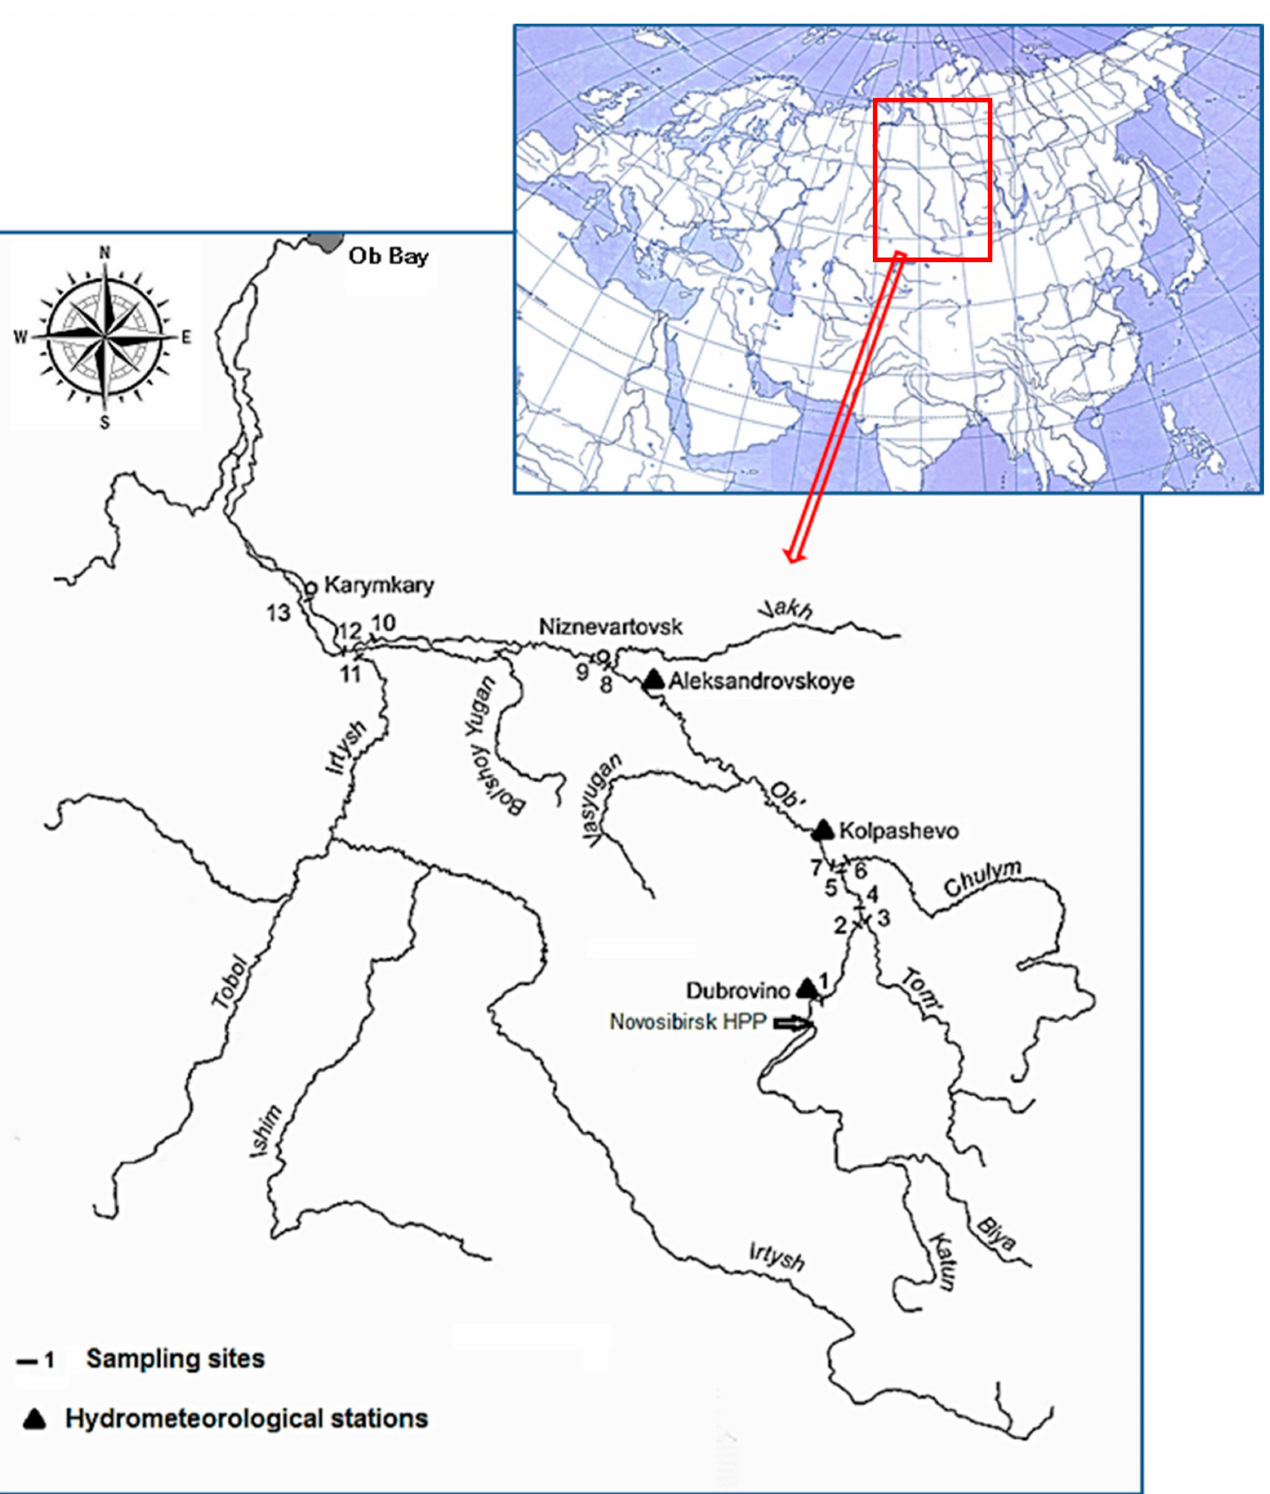
Figure 1. Schematic map of sampling sites (sites numbers correspond to those specified in Table